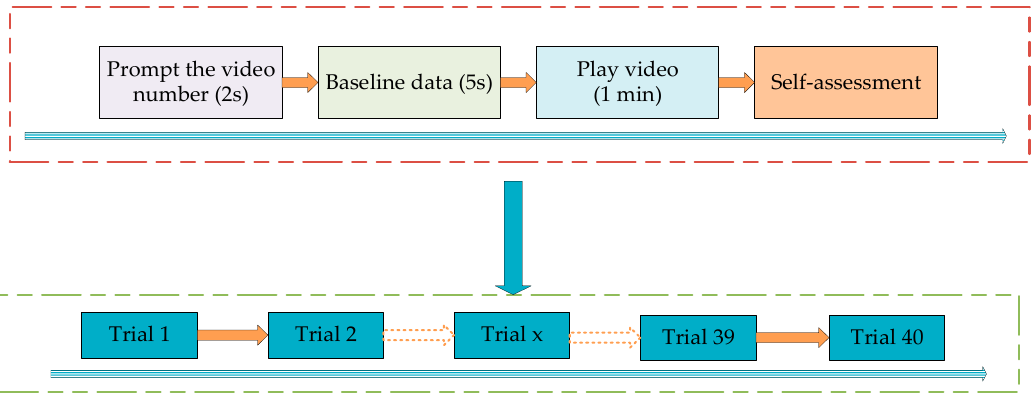
Figure 3. Experiment process.